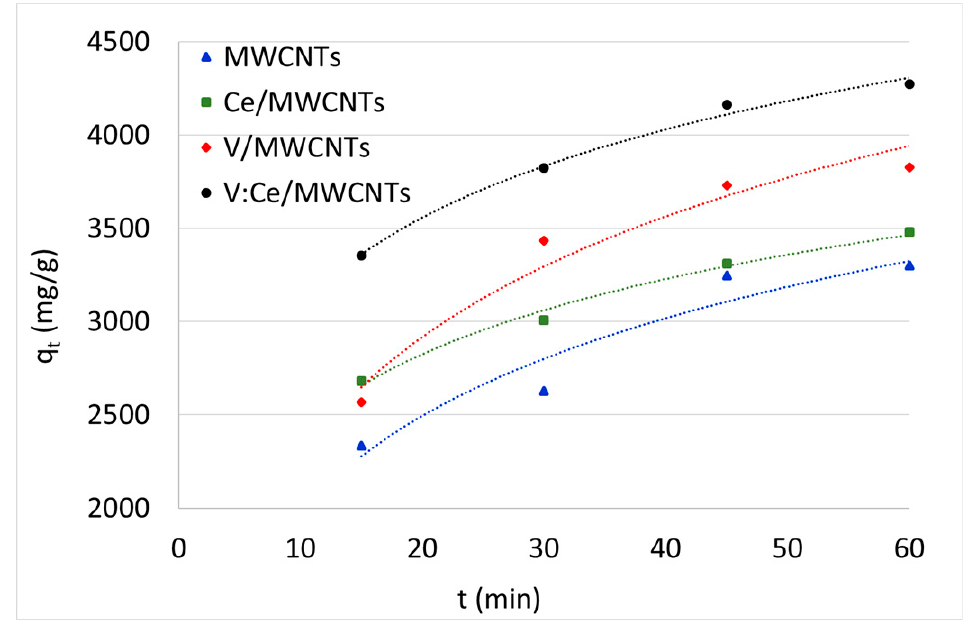
Figure 10. Adsorption capacity of kerosene against the time over fresh and modified MWCNTs.